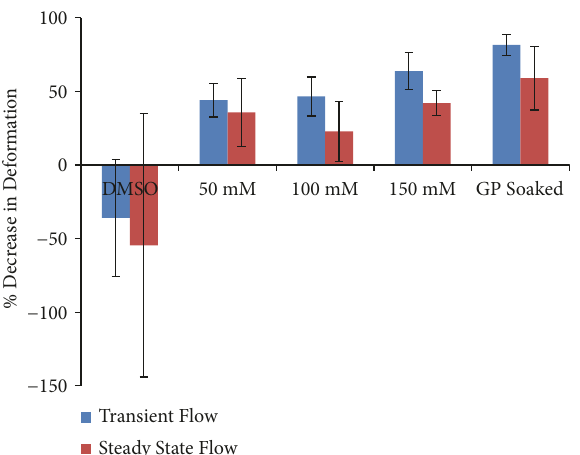
Figure 2: Soft palate deformations. Soft palate free end deformation change from pretreatmentto posttreatmentin both transient and steady- state flow. Data are mean ± SD